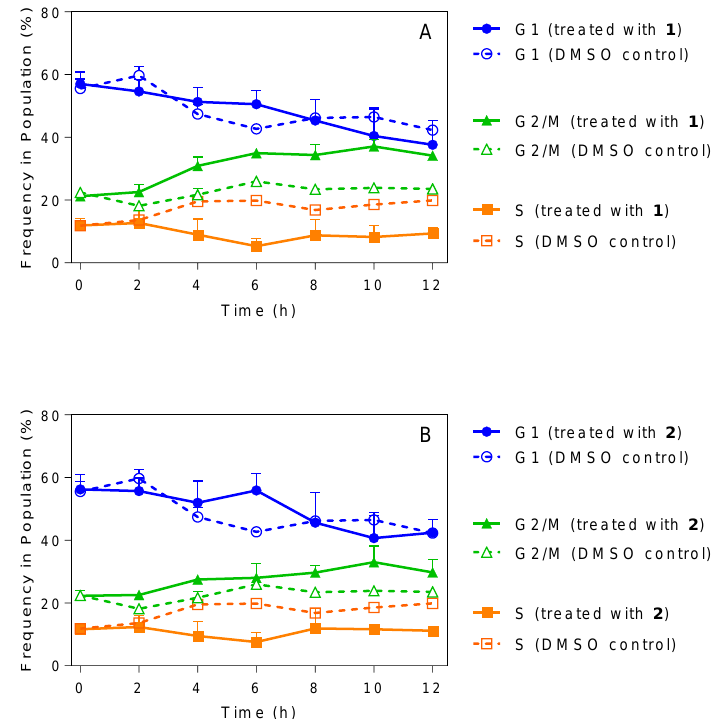
Figure 3. DNA content of T. b. brucei cells for ( A ) = cells treated with 4× EC 50 1 ; ( B ) = cells treated with 4× EC 50 2 ; error bars represent SD; data for frequency in population. Graphs depict DNA content collected by flow cytometry. The percentages of each cell cycle stage were plotted as a frequency of the total cell population (%) over 12 h.